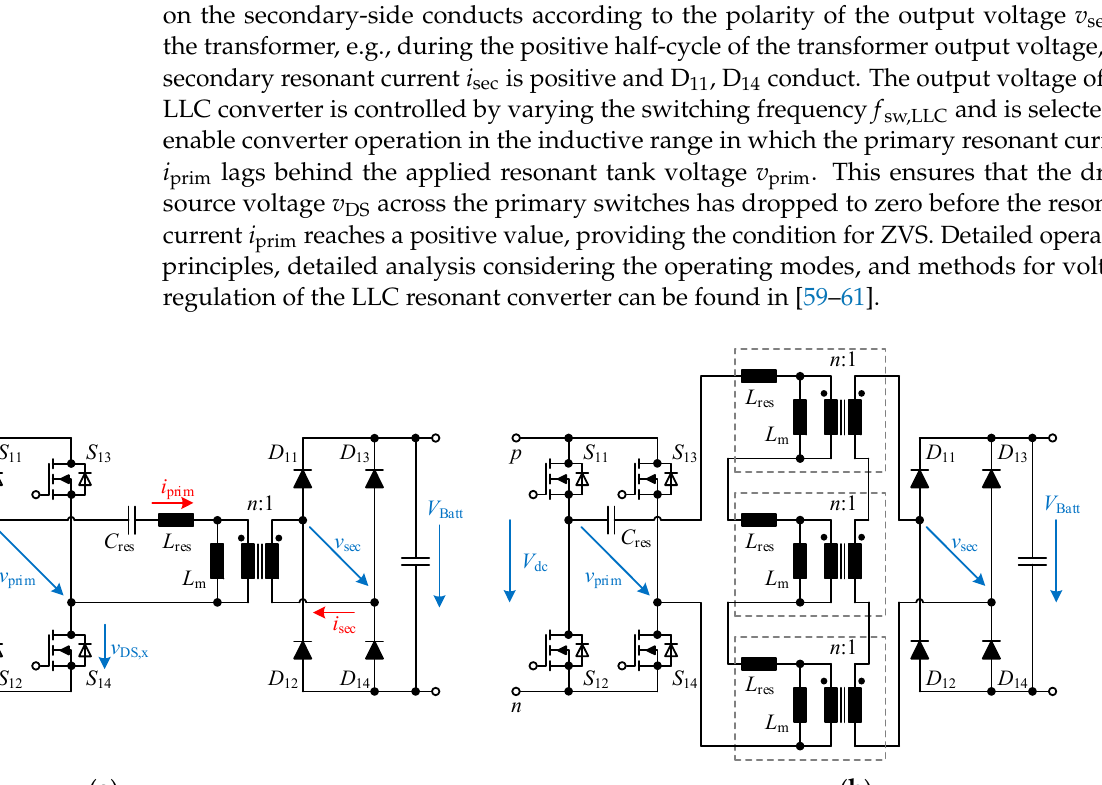
Figure 13. Considered topologies for the dc/dc stage: LLC resonant converter in: ( a ) single-phase implementation and ( b ) single-phase implementation with split transformers.